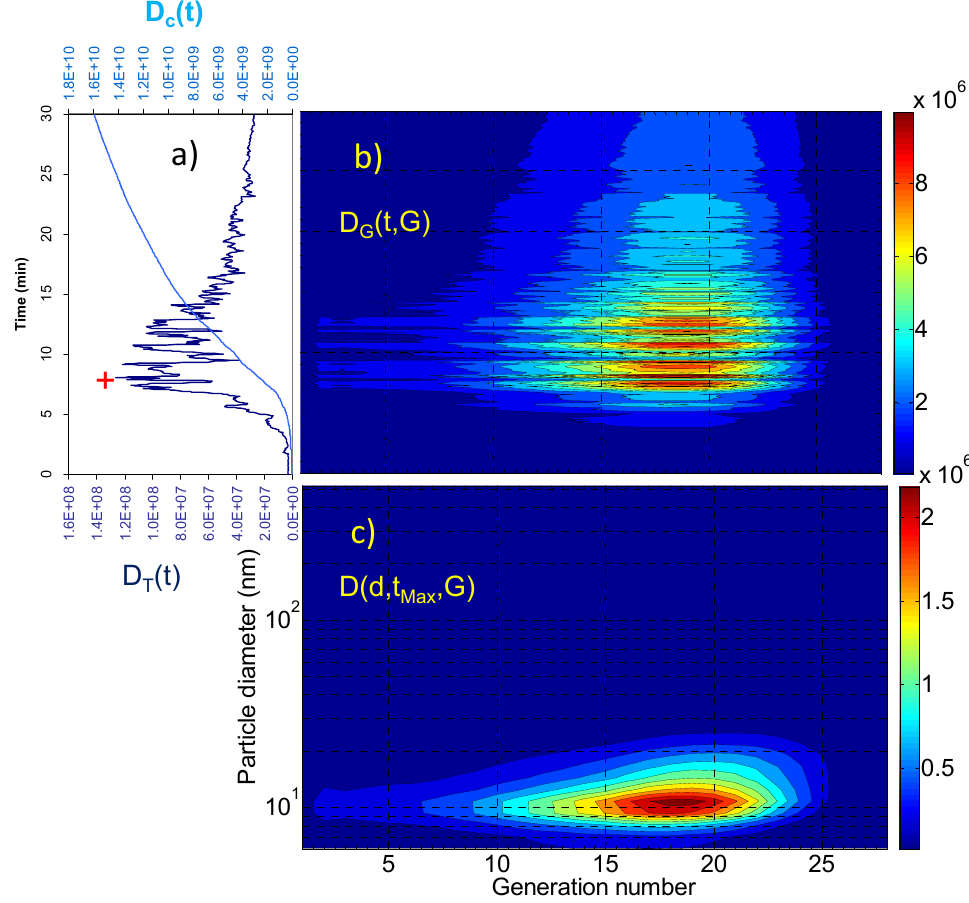
Figure 6. Kitchen, breakfast preparation and eating: ( a ) total instant dose D T (t) and cumulative dose D c (t) as a function of time; ( b ) instant dose per airway generation D G (t,G) as a function of time and airway generation number; ( c ) maximum instant dose D(d,t Max ,G) at the maximum D T (t) value (the red cross in (a)) as a function of particle diameter and of airway generation